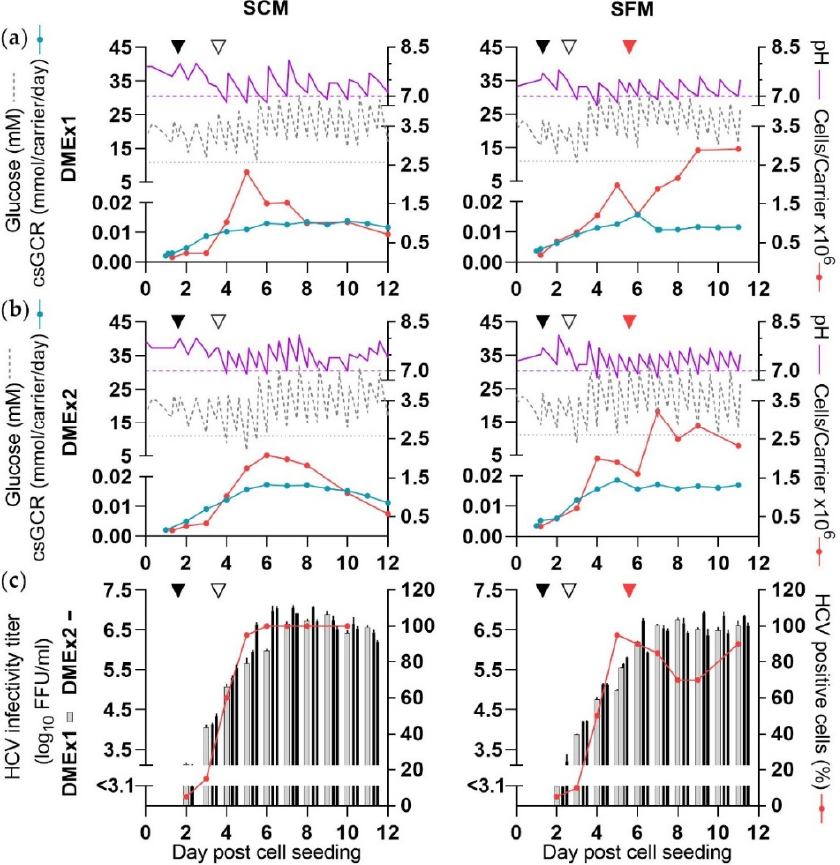
Figure 4. Evaluation of the influence of medium exchange frequency on HCV yields in shake flasks (ShF-DMEx1-SCM, ShF-DMEx2-SCM, ShF-DMEx1-SFM, ShF-DMEx2-SFM). The cultures were seeded with 2 × 10 5 cells/carrier and infected with 6.8 × 10 4 FFU at 1 dpcs (black arrow). Purple dashed line: pH 7, grey dotted line: 11 mM glucose. Different DME frequencies, ( a ) DMEx1, morning versus ( b ) DMEx2, morning and evening, were initiated at 3 dpcs or 2 dpcs in left and right panels, respectively (open arrow). Glucose and/or NaHCO 3 solution was added, glucose concentration and pH were measured, and carriers were sampled as described in Figure 1. In the indicated cultures SF conditions were applied from 5 dpcs (red arrow). ( a , b ) Glucose concentration, pH, csGCR, and cells/carrier. ( c ) HCV infectivity titers and percentage HCV NS5A positive cells; the curve represents both cultures as identical values were recorded throughout the experiment. Table 2. Overview of cultivation parameters, rates, and yields of shake flask experiments.